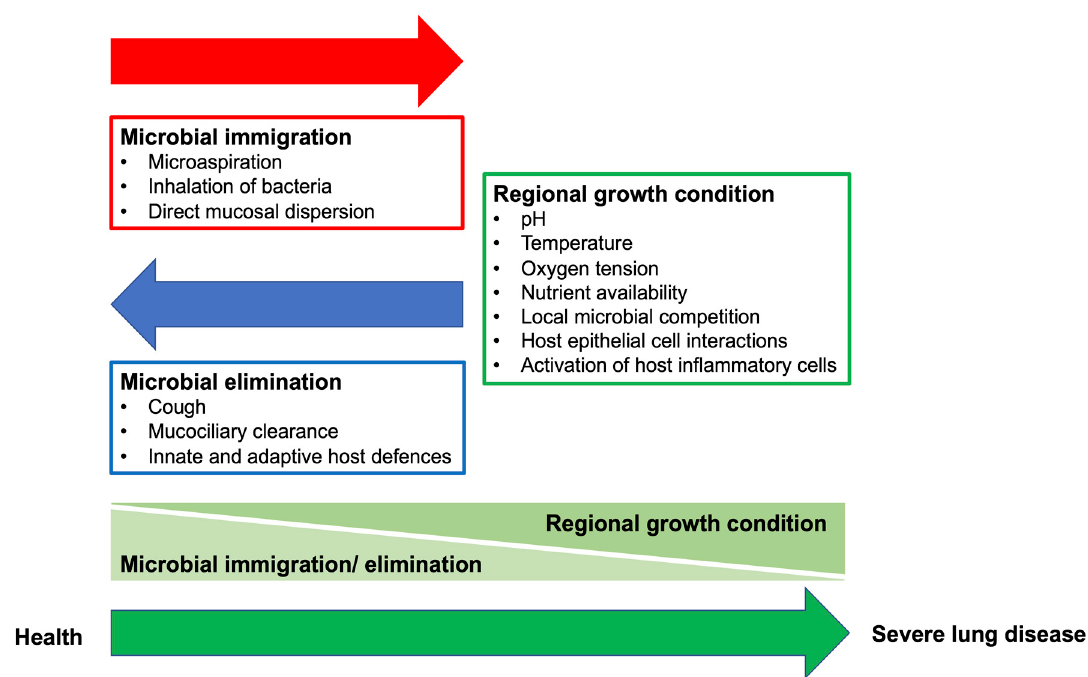
Figure 1. Key Ecological Factors Determining the Lung Microbiome: microbial immigration, microbial elimination, and the relative reproduction rates of its community members. The lung microbiome is determined mainly by microbial immigration and elimination in healthy subjects. In severe lung disease, the composition of lung microbiome is primarily determined by regional growth conditions. Adapted from Dickson et al., 2014 [27].